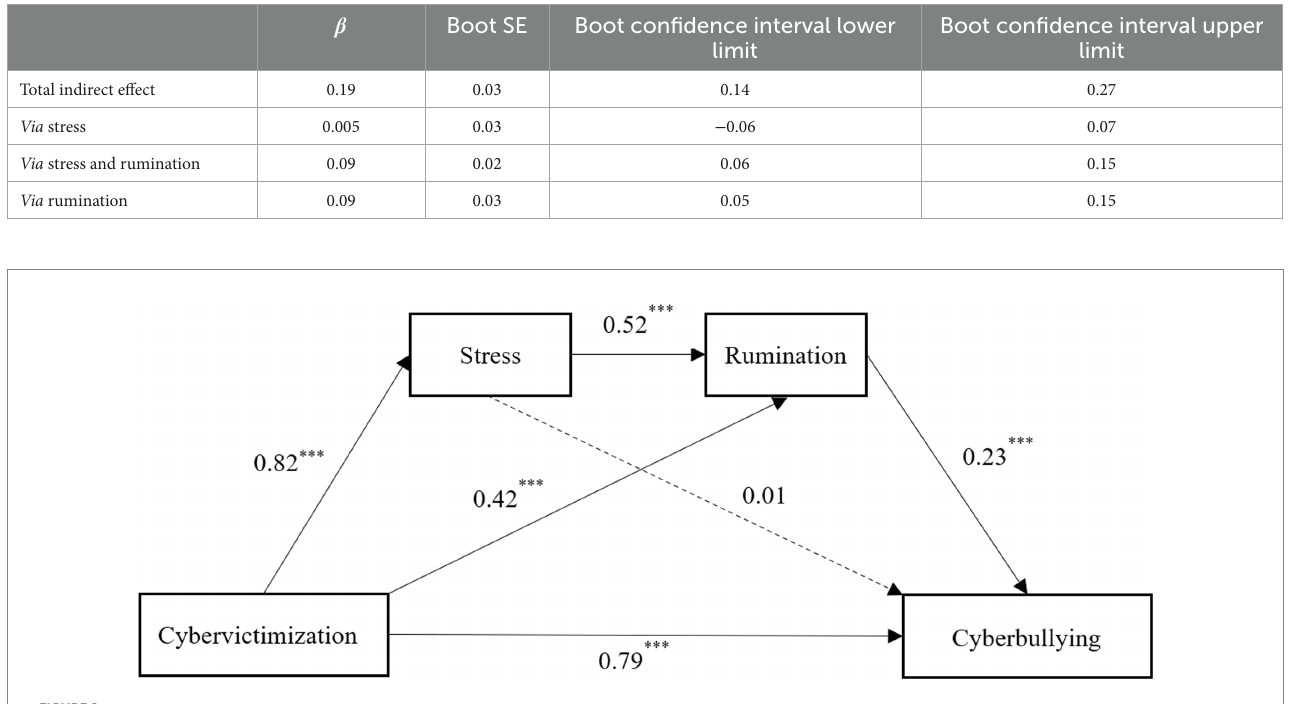
FIGURE 2 Model of the chain-mediating effects of stress and rumination on the relationship between cybervictimization and